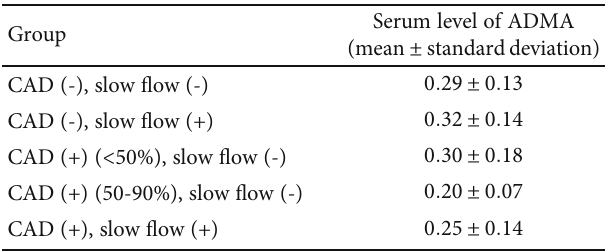
Table 1: Comparison of the mean serum concentration of ADMA in study groups.